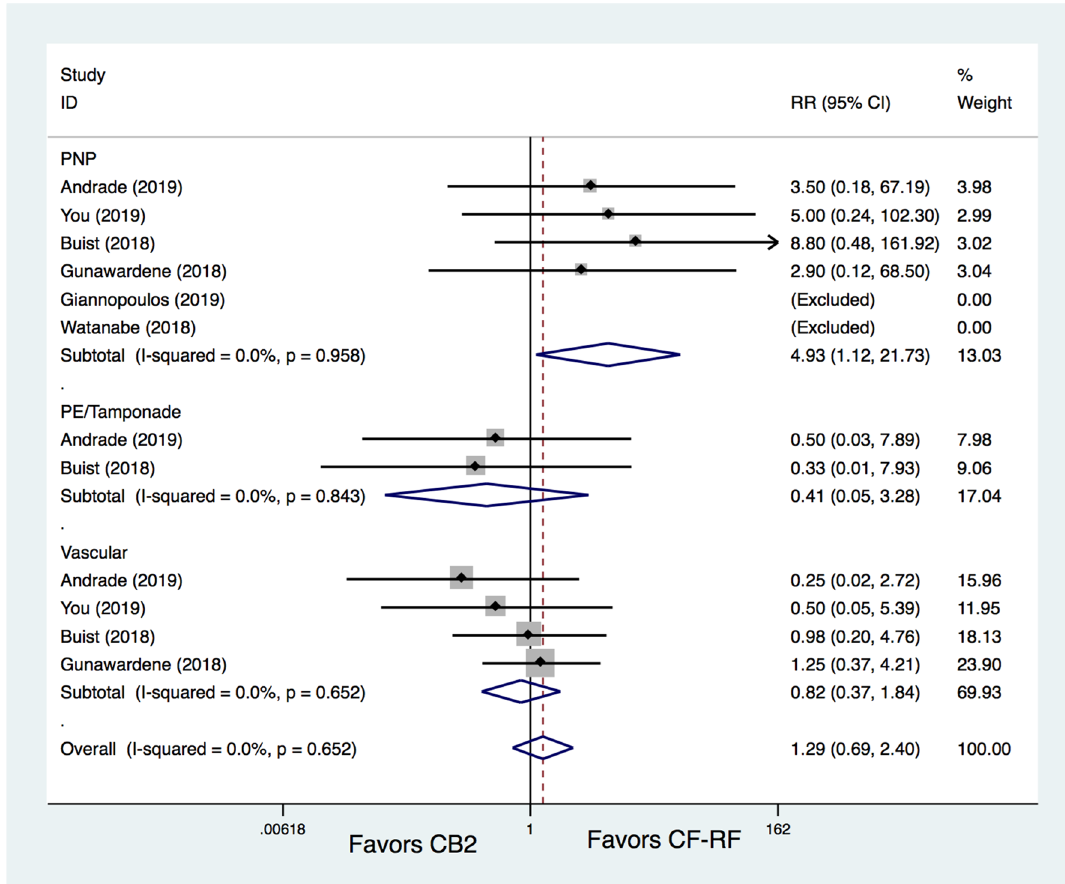
Figure 5. Subgroup meta-analysis for the outcome of complications. PN p = phrenic nerve palsy; PE = pericardial effusion; RR = relative